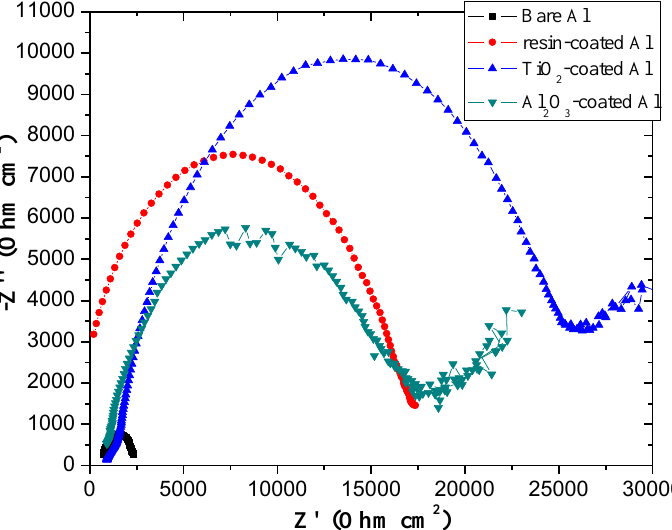
Figure 4. Nyquist plots for the studied samples.